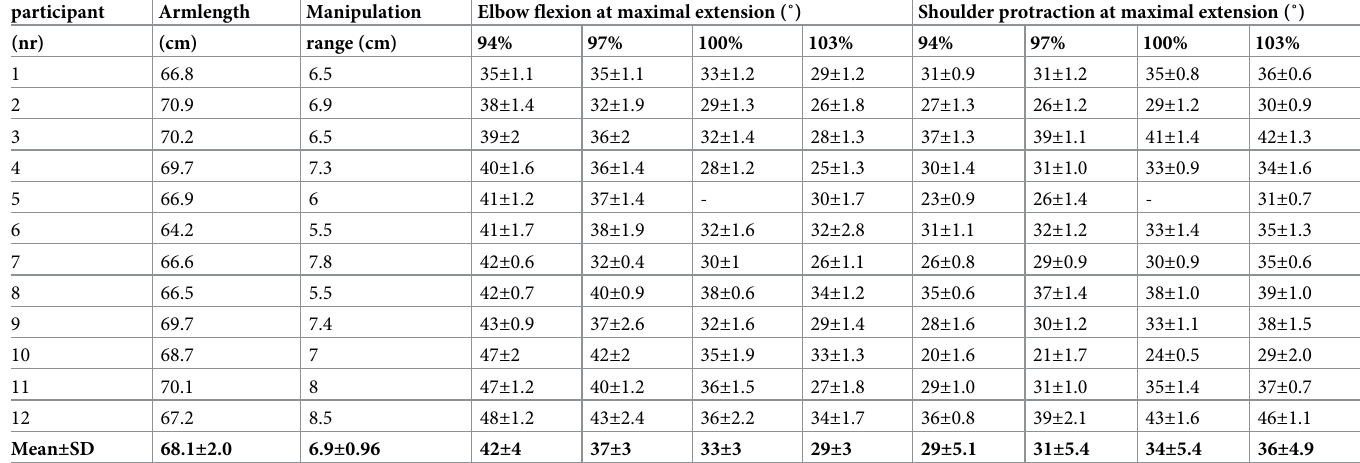
Table 1. Arm length, manipulation range and mean elbow flexion (mean ± SD) and shoulder protraction angles (mean ± SD) at maximal extension for each partici- pant in each configuration (at 30W & 60W). participant